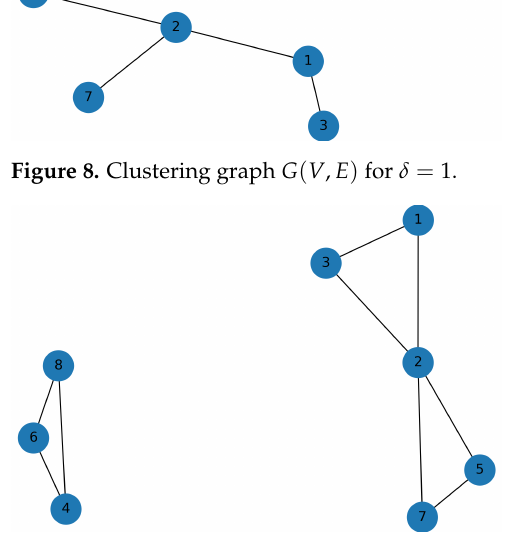
Figure 9. Clustering graph G ( V , E ) for δ = 2.